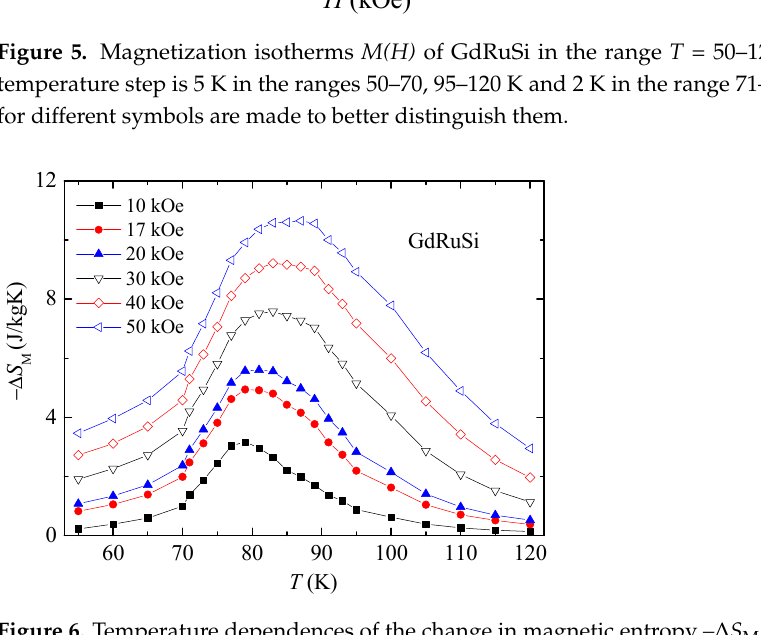
Figure 6. Temperature dependences of the change in magnetic entropy – ∆ S M ( T ) in a field changing to 10–50 kOe for GdRuSi.